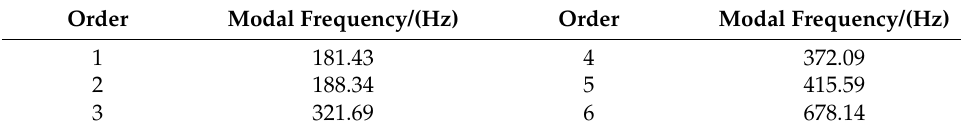
Table 3. The first Sixth-order modal frequency of the seedling picking mechanism.